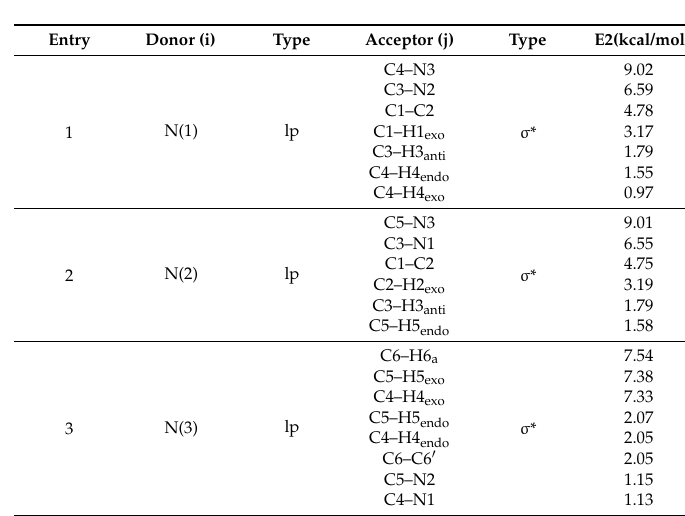
Table 4. Selected second-order perturbation energy (E(2) kcal/mol) with values greater than 1 kcal/mol associated with electronic delocalization between nitrogen lone pairs (i) and acceptors (j) of ETABOC calculated at the B3LYP/6-311G(d,p) level of